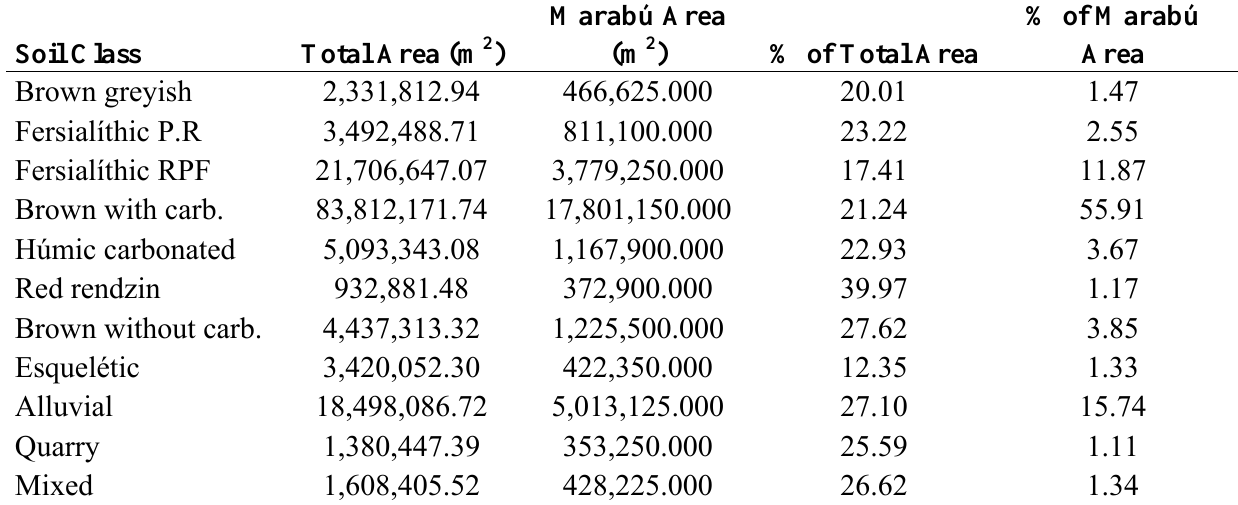
Table 4. Distribution of Marabú thickets ( Dychrostachys cinerea ) by soil class (2005). Soil